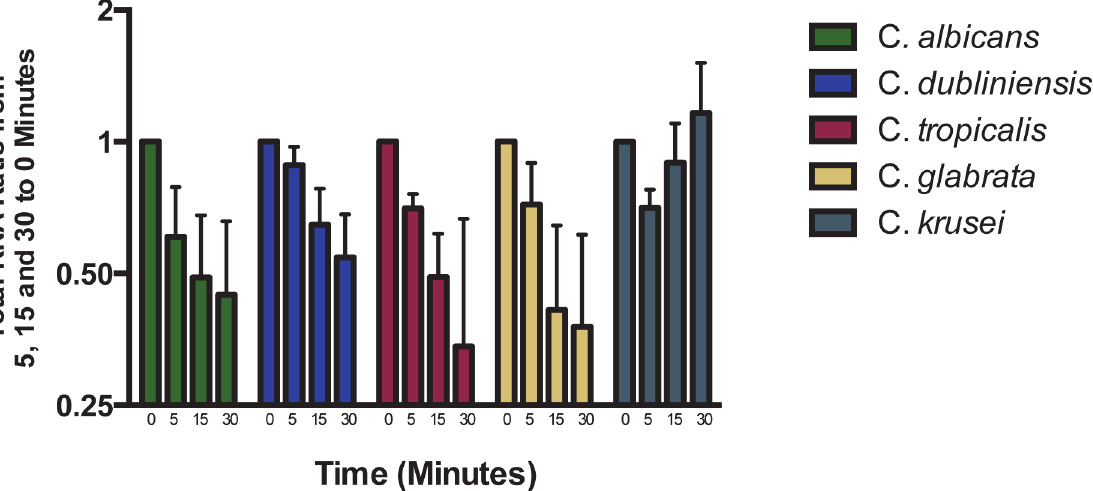
Fig 5. Time course of RNA content changes on hyphal stimulation in C . albicans and several other Candida species. Bars represent ratios of total RNA content at end of hyphal stimulation for noted time periods to RNA content prior to stimulation. Assays were done with water plus 10% FBS at 37°C. Each bar represents combined data from 2 assays and error bars represent